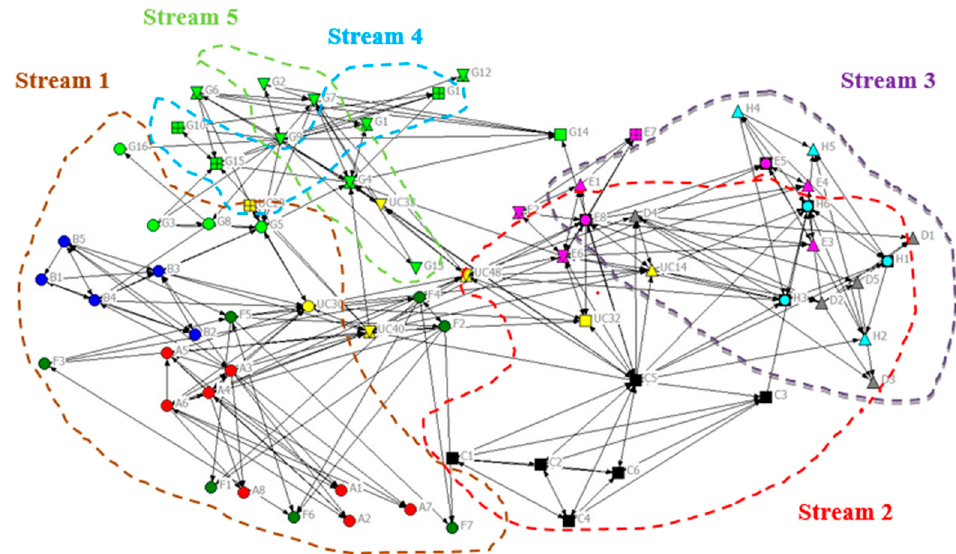
Figure 3. Phase 1 sociogram for preferred idea sharing (strength of tie = 3). *Same organisation and key contact attribute display in Figure 2. To more clearly discern the impact of project grouping on trust, Figure 4 excludes all UC managers except the seven most senior managers of the two high-level production unit groups and five subordinate streams whilst retains all contractor staff. To see more clearly the project groupings, coloured boundaries enclosing all the nodes (individual) belonging to the stream are added to Figure